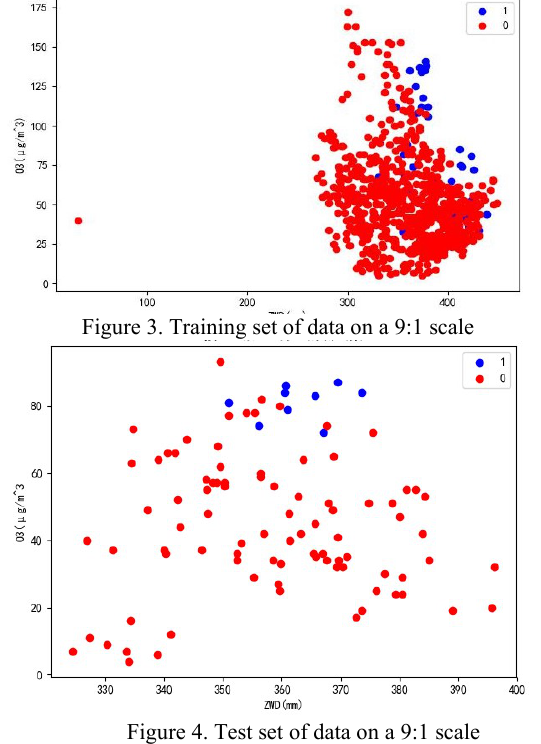
Figure 5.The result of the default model